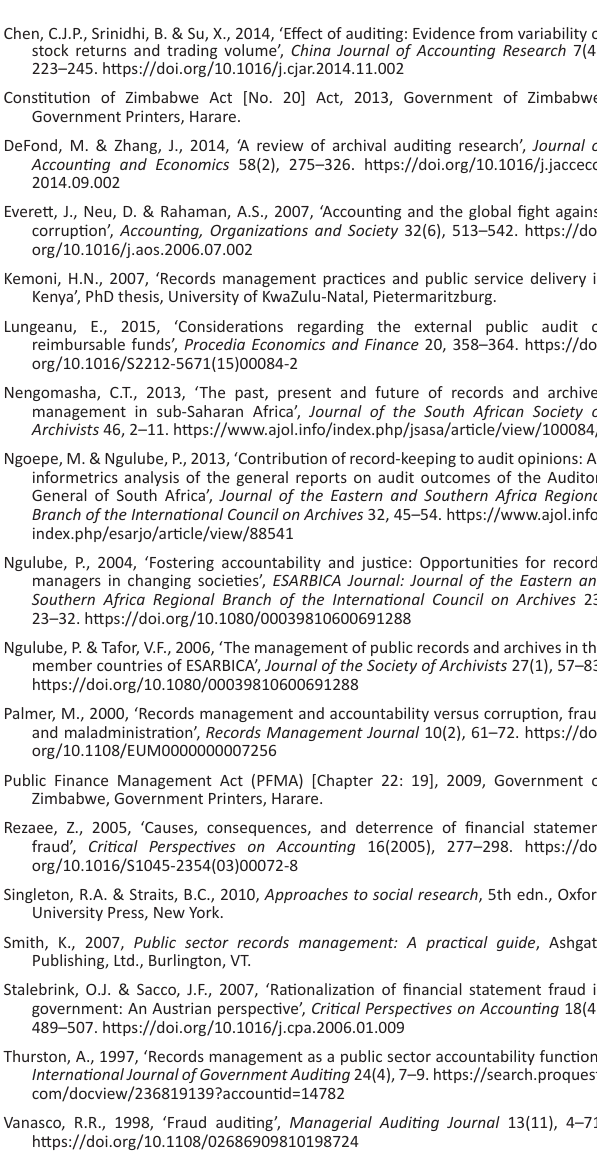
FIGURE 9: The Comptroller and Auditor General of Zimbabwe Narrative Report for the financial year ended 31 December 2011 for Appropriation Accounts and Miscellaneous Funds and Donor-Funded